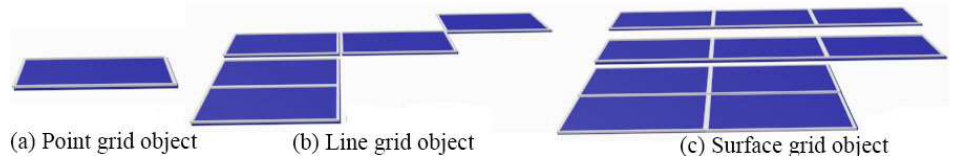
Figure 1. The geometric representation of the grid object.